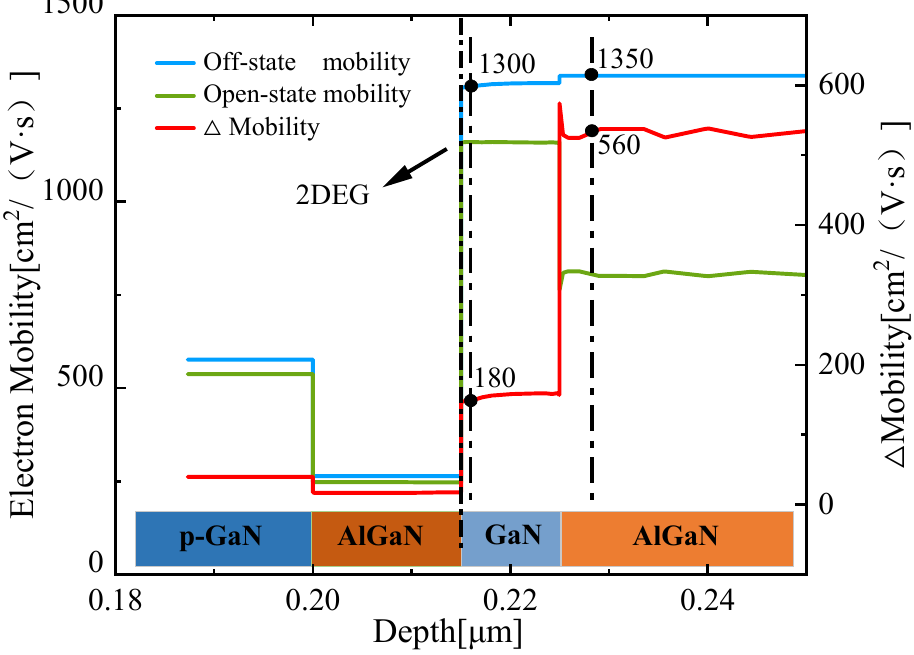
Figure 5. The electron mobility (blue and green line, left Y-axis) and ∆ mobility (red line, right Y-axis) in the enhancement-mode p-Gate AlGaN/GaN HEMT of different operation modes.